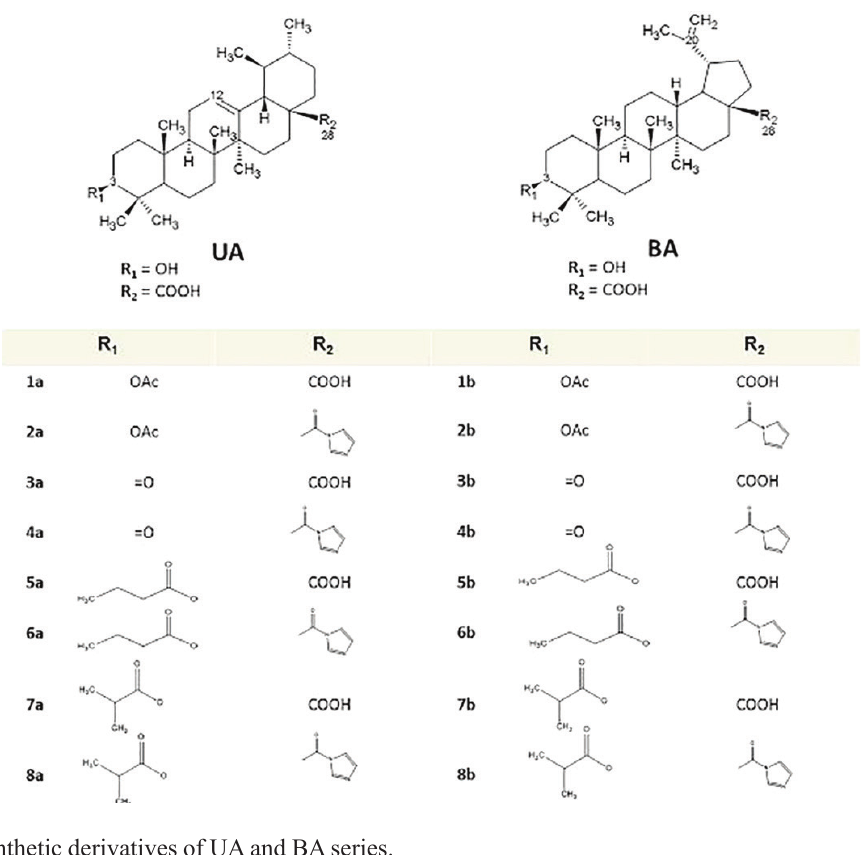
FIGURE 2 – Semisynthetic derivatives of UA and BA series.